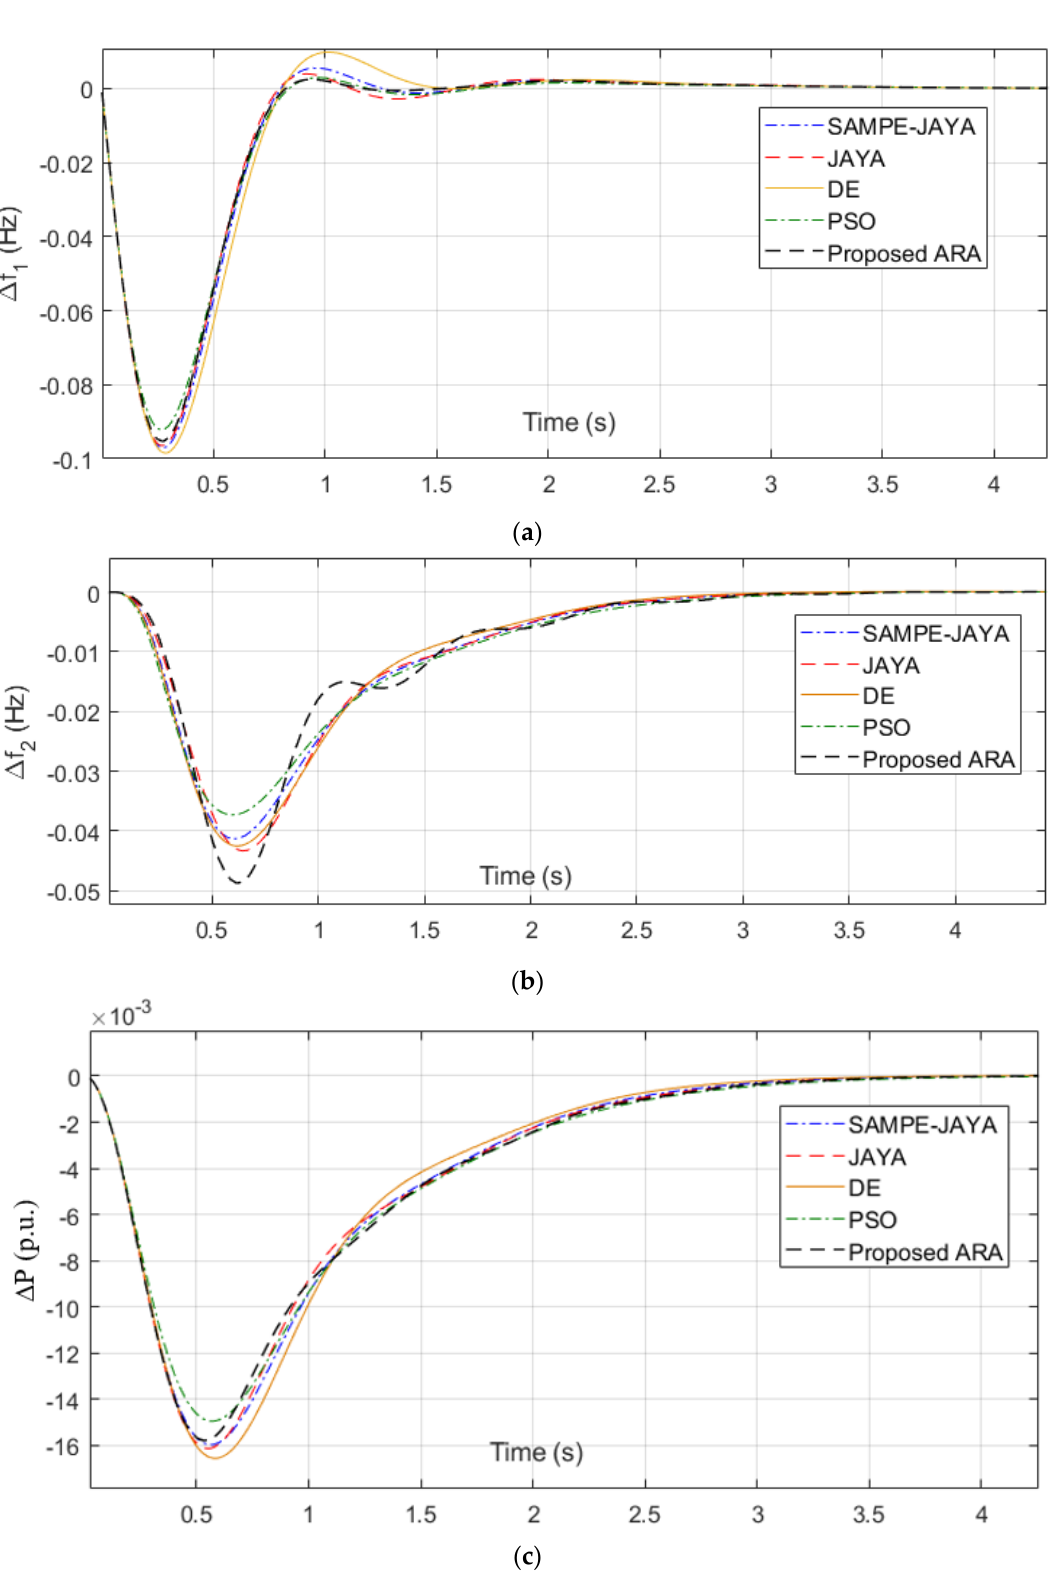
Figure 4. Dynamic responses for SAMPE-JAYA, JAYA, DE, PSO and the proposed ARA under case study 1. ( a ) Change in frequency in area 1. ( b ) Change in frequency in area 2. ( c ) Tie-line power deviation.